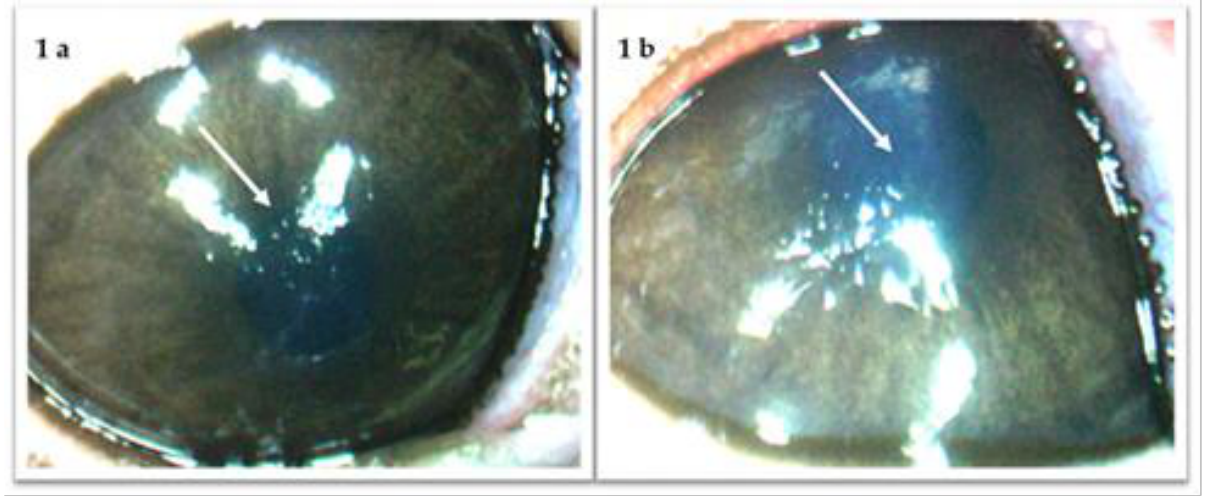
Figure 1. ( a ) Cornea treated with SafeCross ® ; ( b ) Haze in cornea treated with riboflavin + 0.10% EDTA. Seven days after surgery, corneas treated with SafeCross ® solution were not stainable with a fluorescence dye, showing a complete re-epithelization (Figure 2a), while positive fluorescence staining persisted in 40% of corneas treated with riboflavin + 0.10% EDTA (Figure 2b).